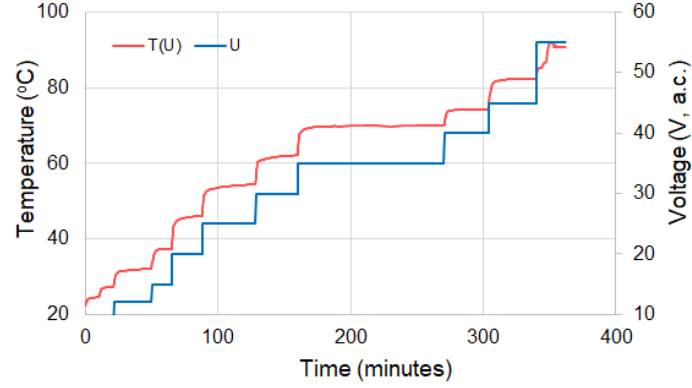
Figure 16. T s vs. time and applied voltage for a (CB + Gr)/HD composite.